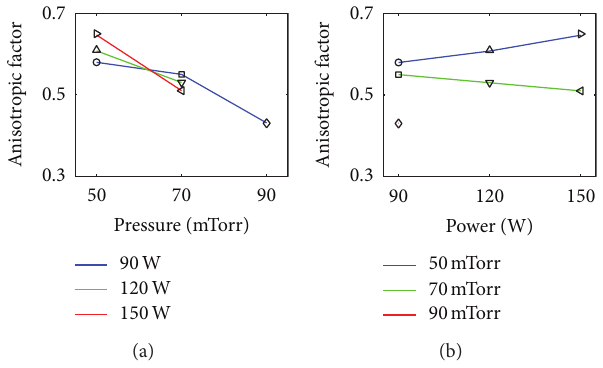
Figure 6: Dependence of the anisotropic factor on pressure (a) and power (b).